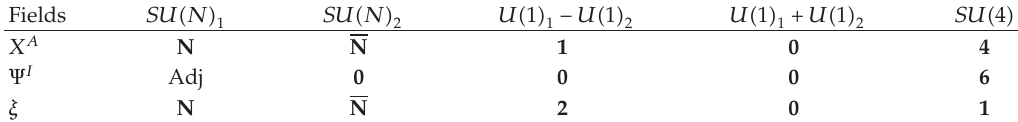
Table 1: Matter content and